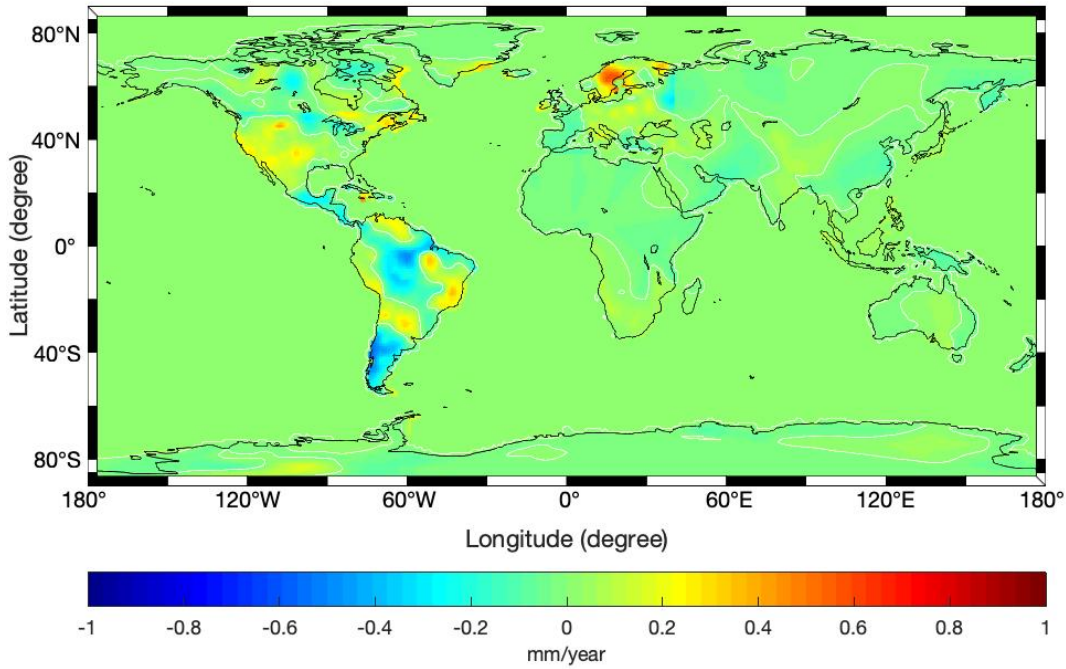
Figure 11. Di ff erences in uplift rates of ICE6Gavg (GPS) with respect to ICE6Gavg. The zero-di ff erence contours are indicated by white curves.